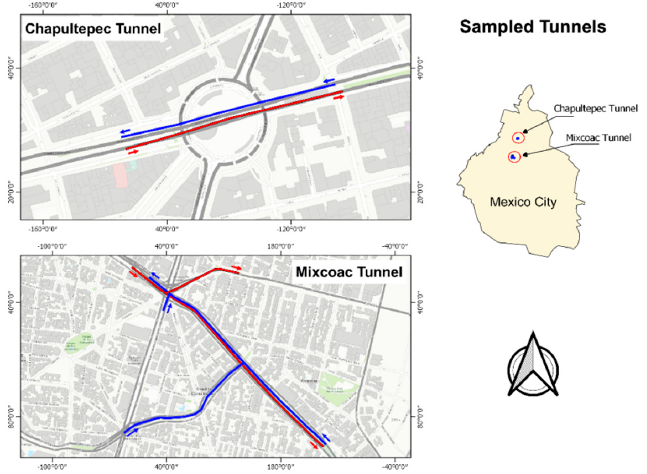
Figure 1. Location of the sampled